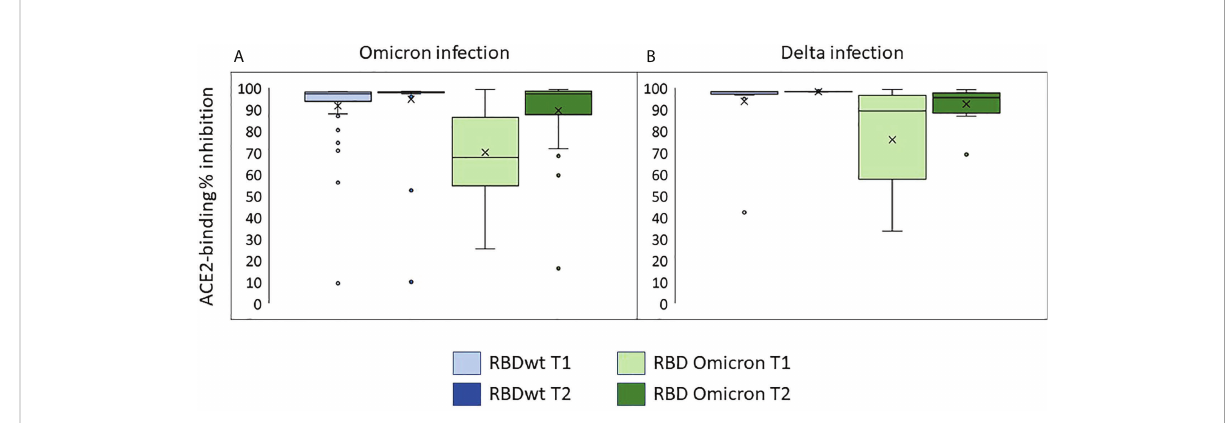
FIGURE 3 Neutralizing antibodies in individuals infected with Omicron or Delta. The plots show inhibition of ACE2-binding to RBD from SARS-CoV-2 wild type or Omicron (BA.1) in % of control (sera with no detectable anti-RBDwt IgG). T1: inclusion, T2: one week follow up. (A) Individuals with Omicron infection. (B) Individuals with Delta infection.